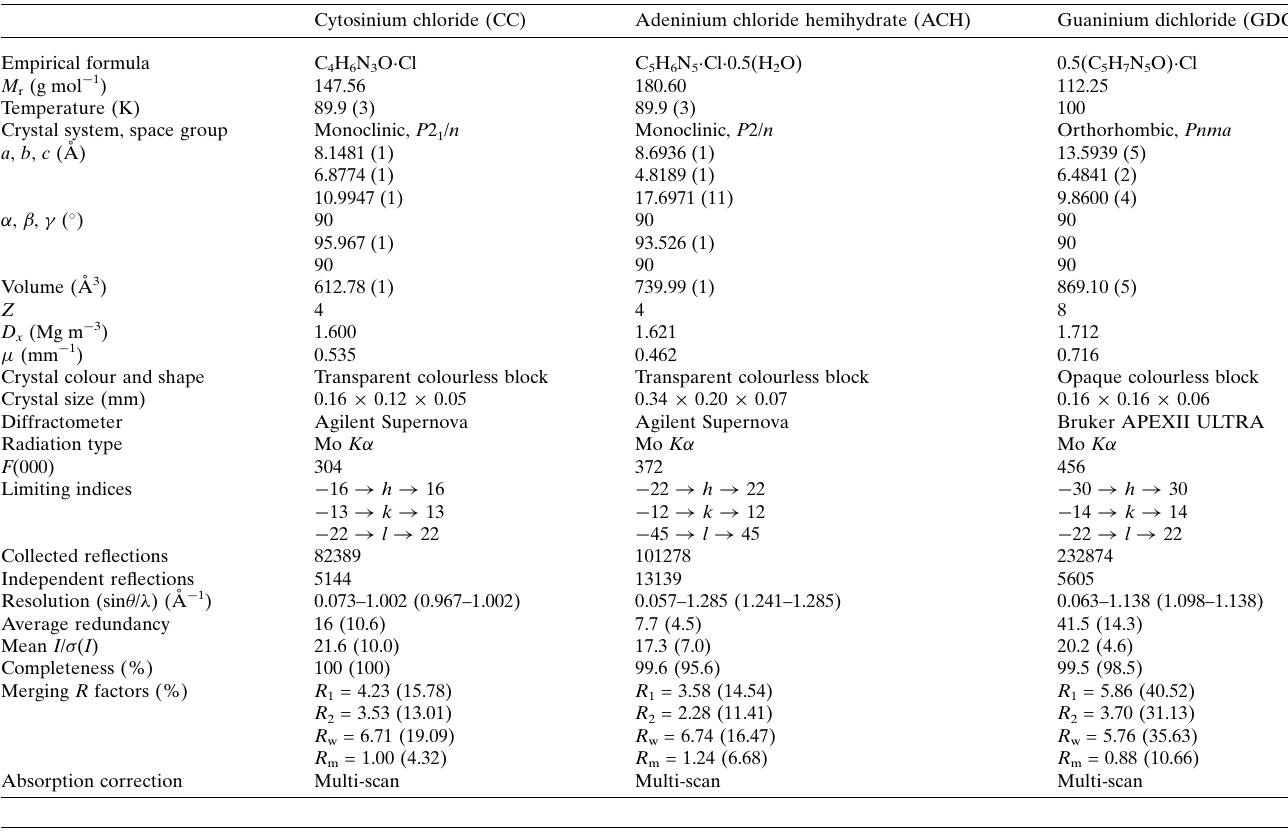
Table 1 Parameters characterizing the X-ray data collection and multipole refinements of the studied crystals. Values in parentheses are for the highest resolution shell.